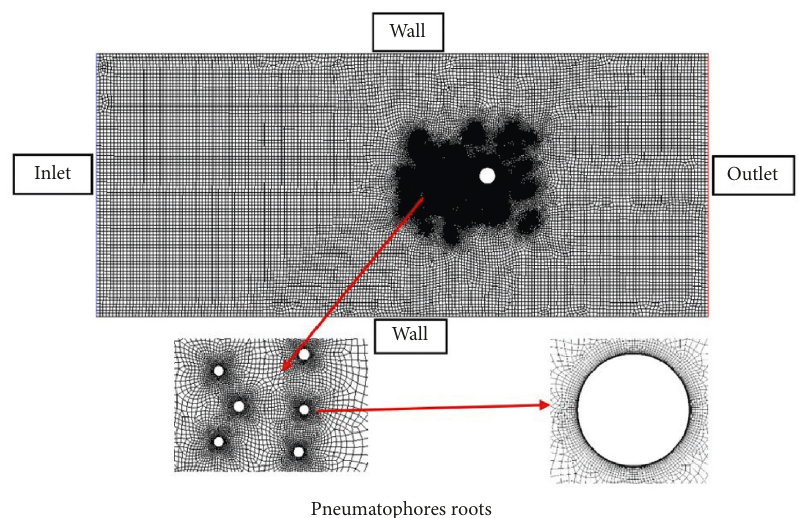
Figure 4: Avicennia mangrove roots grid model created in ANSYS workbench.